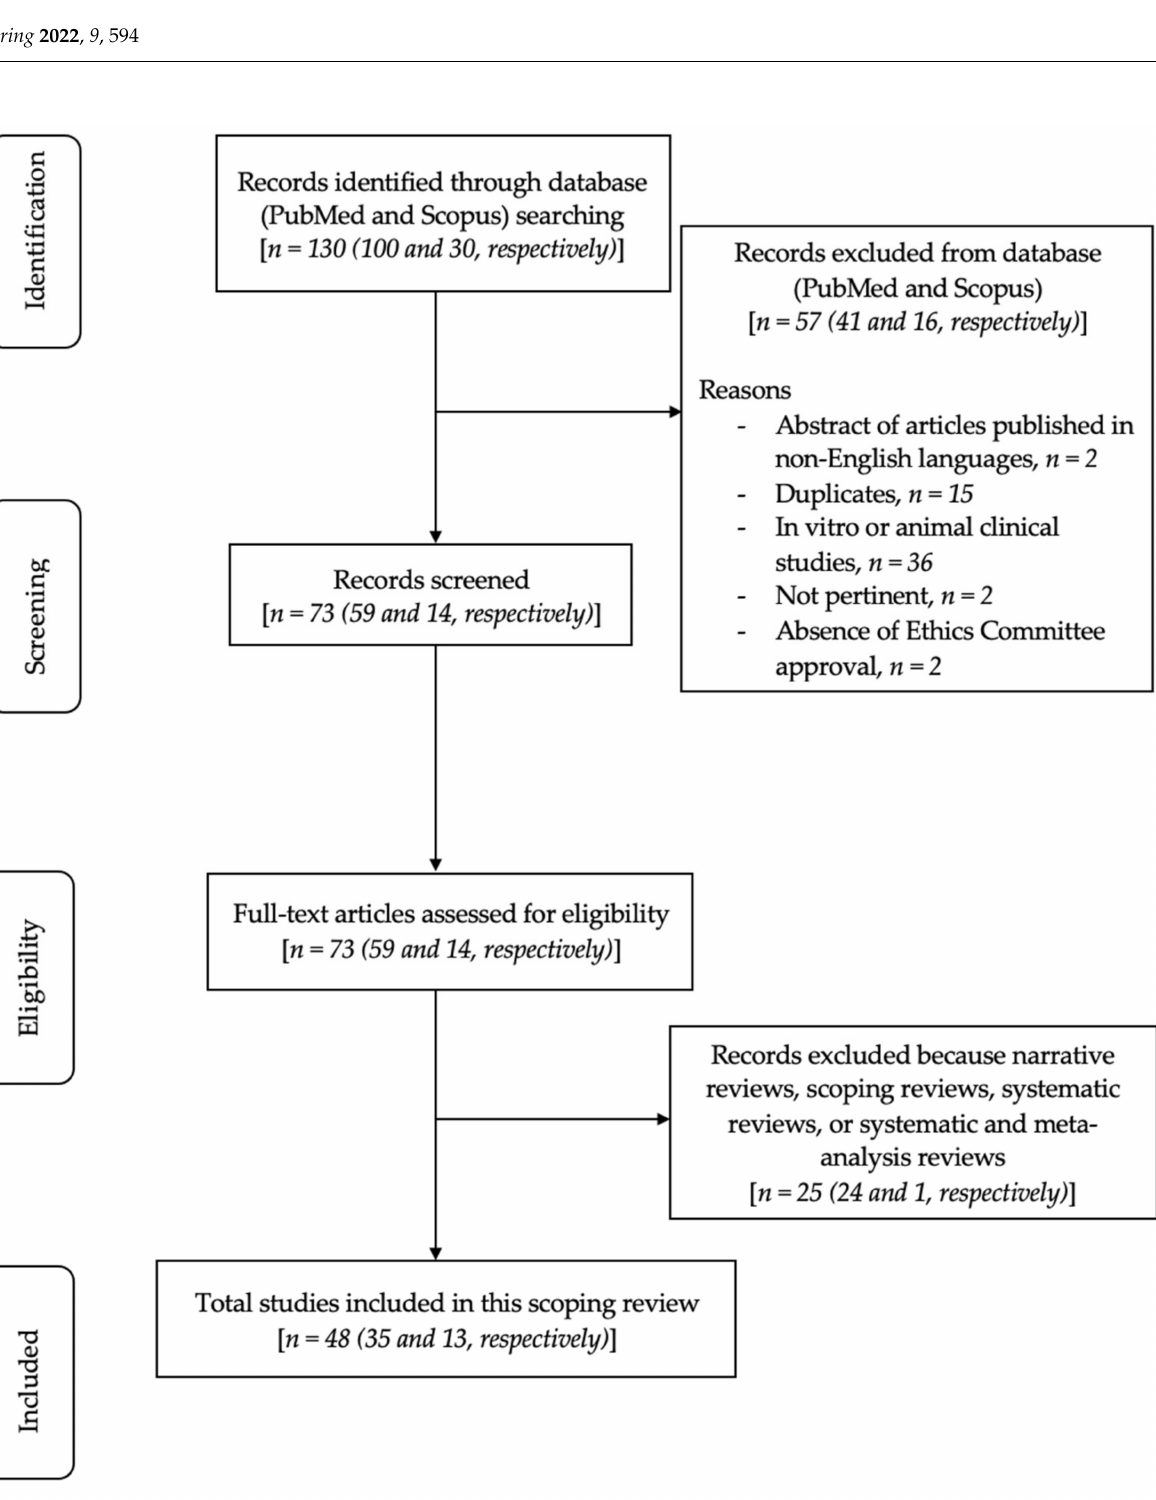
Figure 1. Flowchart of the review